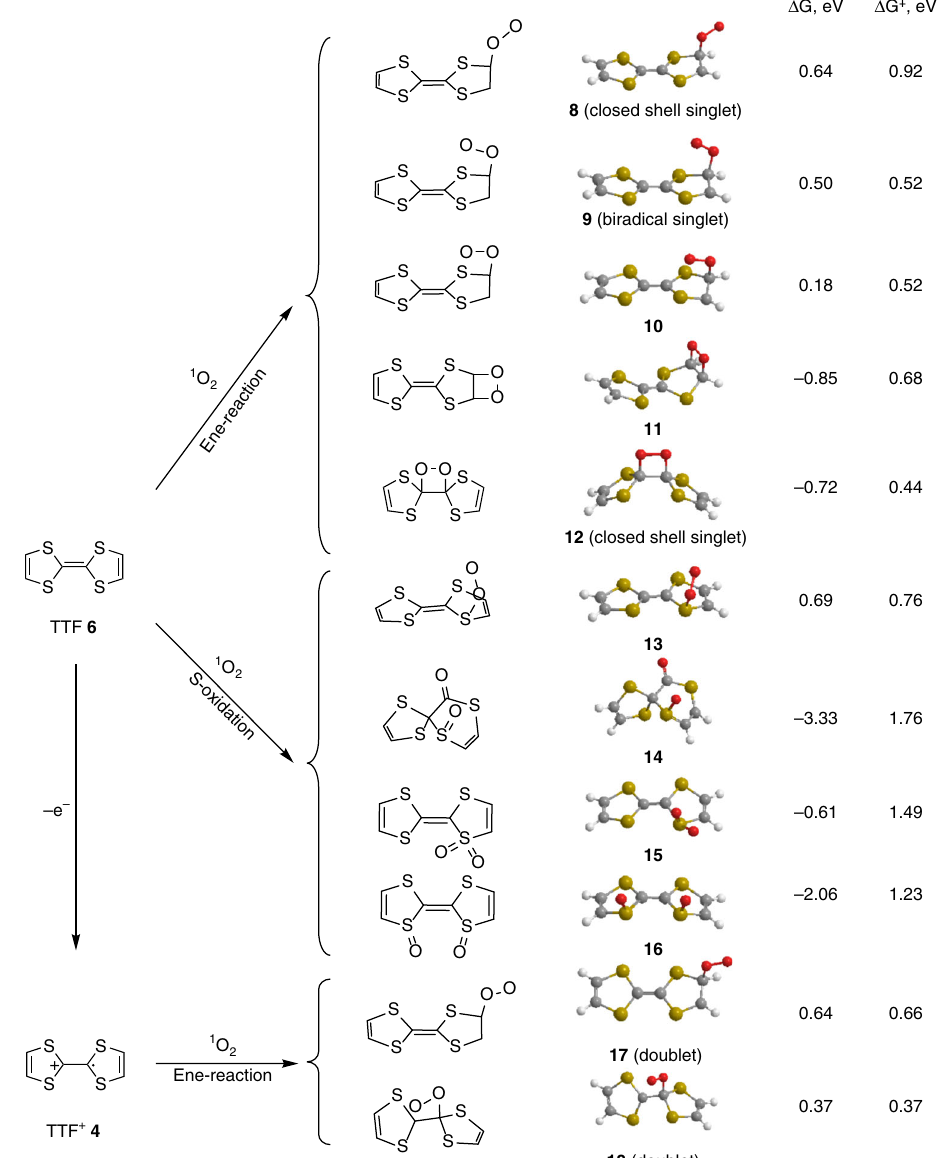
Fig. 5 Reactions and energetics of reactions between TTF and 1 O 2 . Possible reactions of TTF/TTF + with 1 O 2 , B3LYP/6 – 31G* optimized geometries of the reaction products, and DFT-calculated free energies at 298 K ( Δ G) and the barriers for these reactions ( Δ G ‡